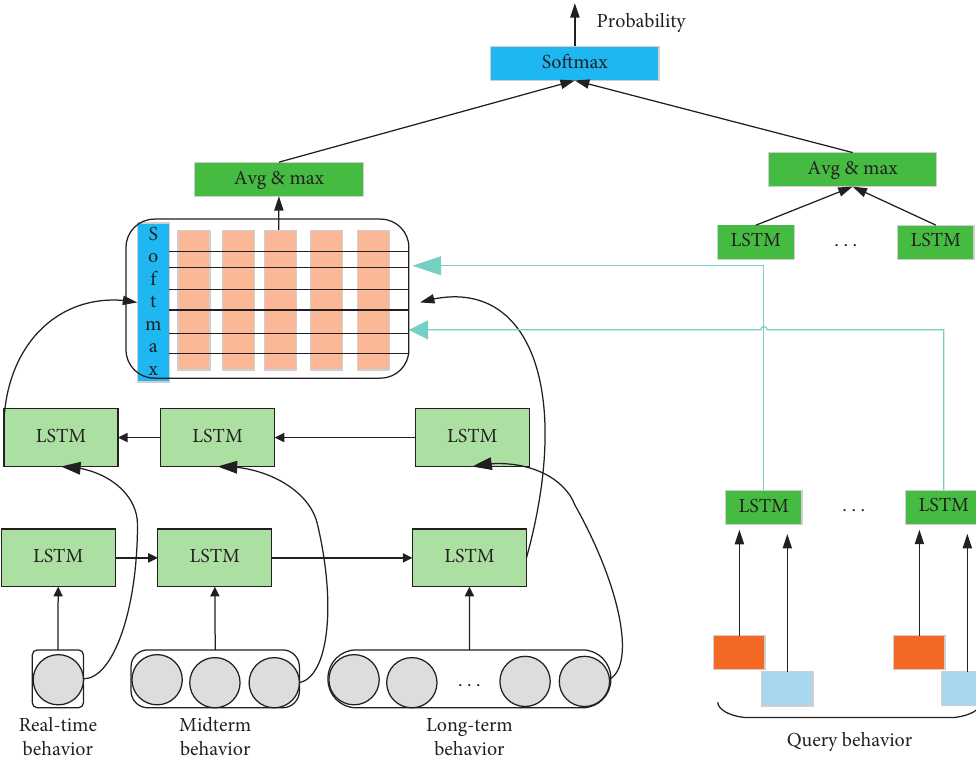
Figure 3: The multidimension time-series model.